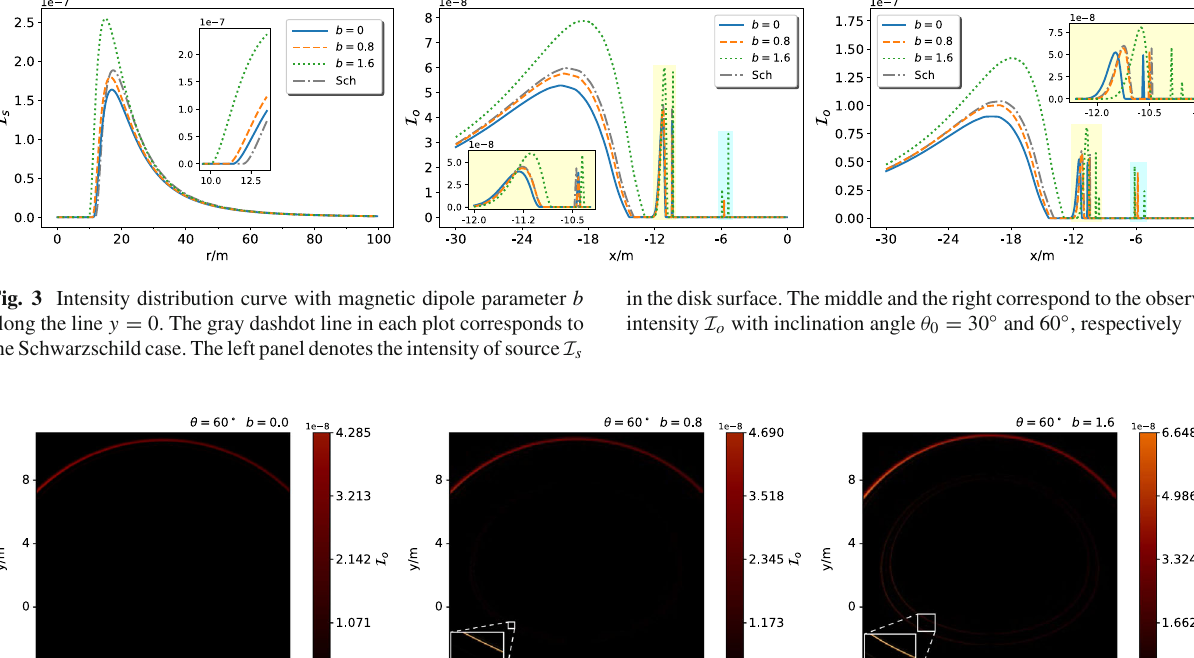
Fig. 4 The fine structures in the image of Bonnor black dihole. In the middle and right panels, the subgraph in the lower left corner is a partially enlarged image of the region marked with a small white